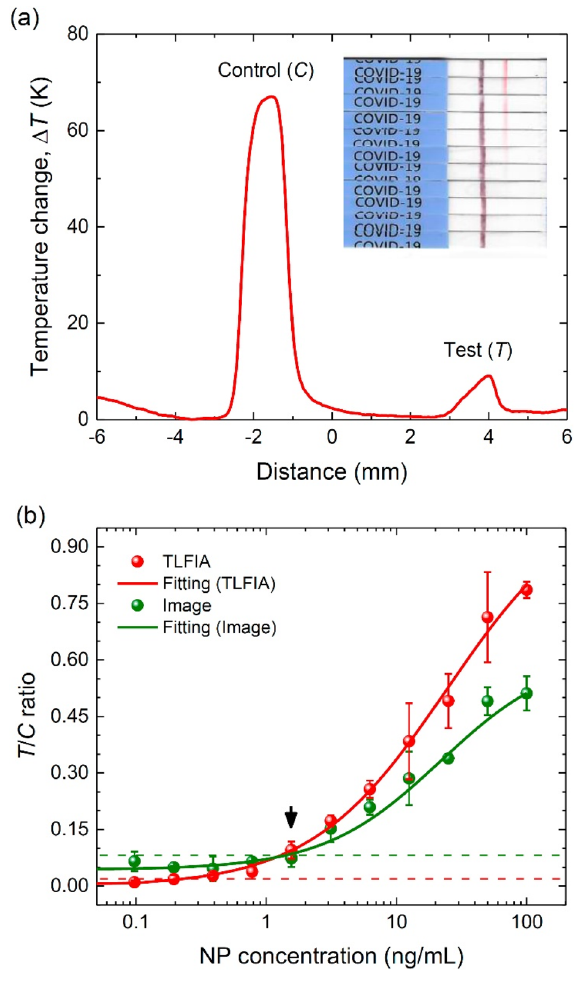
Figure 7. COVID-19 testing with TLFIA. ( a ) Temperature profile of CLBs captured on a COVID-19 antigen test strip, obtained with the TLFIA reader. The assay is conducted for NPs of the SARS-CoV-2 virus at the concentration of 1.56 ng/mL. Integrated areas of the two peaks denoted by “Control ( C )” and “Test ( T )” are calculated to obtain the T / C ratio. Inset: photograph of COVID-19 antigen test strips after the assays over the NP concentration range of 100–0 ng/mL (top to bottom) through twofold serial dilution. ( b ) Comparative LFIA for SARS-CoV-2 NPs by thermometric detection, image analysis, and color visualization with the rapid antigen test strips for COVID-19. Solid curves are best fits of the experimental data to logistic functions. The black arrow indicates the LOD of visual inspection and the green and red dashed lines indicate the LODs of image analysis and TLFIA,